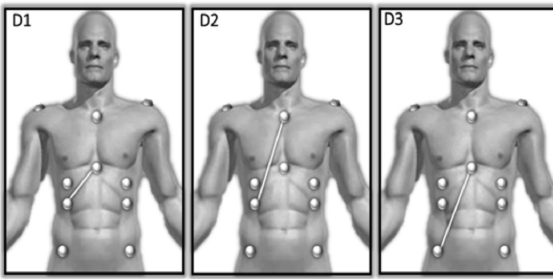
Figure 2 - D1. Xiphoid process/last false rib; D2. Manubrion/ last false rib; D3. Xiphoid process/Antero-superior iliac